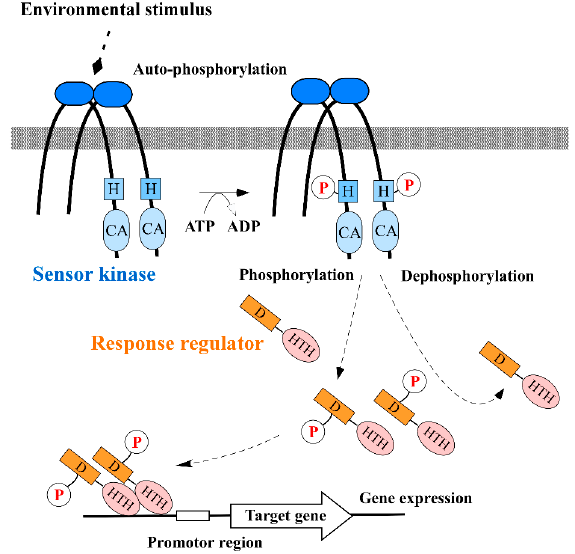
Figure 1. Two-component regulatory system (TCS) in bacteria. When the membrane-bound homo-dimeric sensor kinase senses a particular environmental stimulus, the conserved histidine residue (H) in the cytoplasmic sensor domain of this protein is phosphorylated (P) (termed auto-phosphorylation), then transfers its phosphate group to the conserved aspartate residue (D) in the receiver domain of the cognate response regulator. The kinase activity depends on ATP which is bound to the catalytic domain (CA). The phosphorylated response regulator forms a homo-dimer, then the helix-turn-helix domain (HTH) of the response regulator binds to particular DNA sequences on or close to the promoter of target